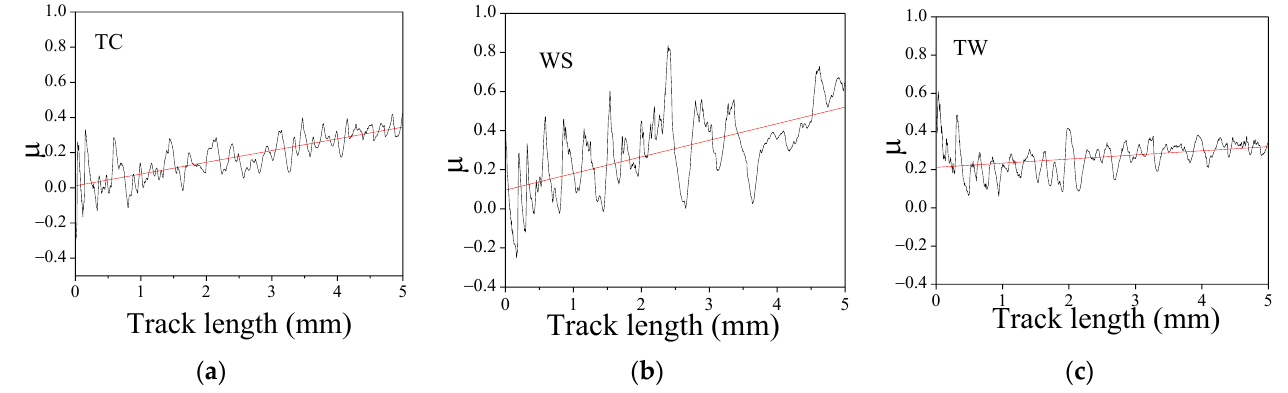
Figure 11. Graphs of changes in the coefficient of friction along the tracks in the TC ( a ), WS ( b ), and TW ( c ) coatings.